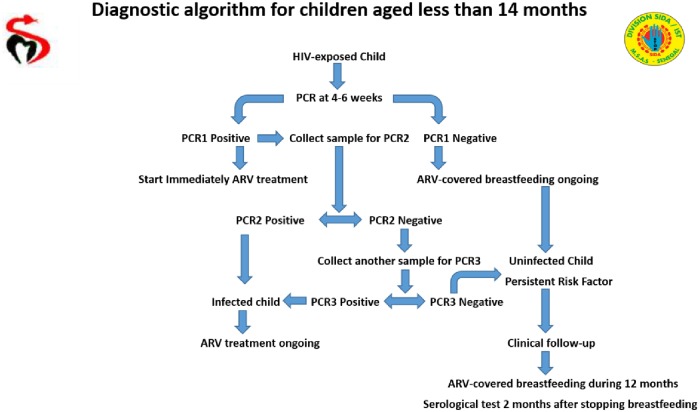
Senegalese algorithm of early infant diagnosis.Regions (blue), Primary sites (green), Secondary sites (yellow), Reprinted with permission from Papa Amadou Niang Diallo to publish it under a CC BY license.